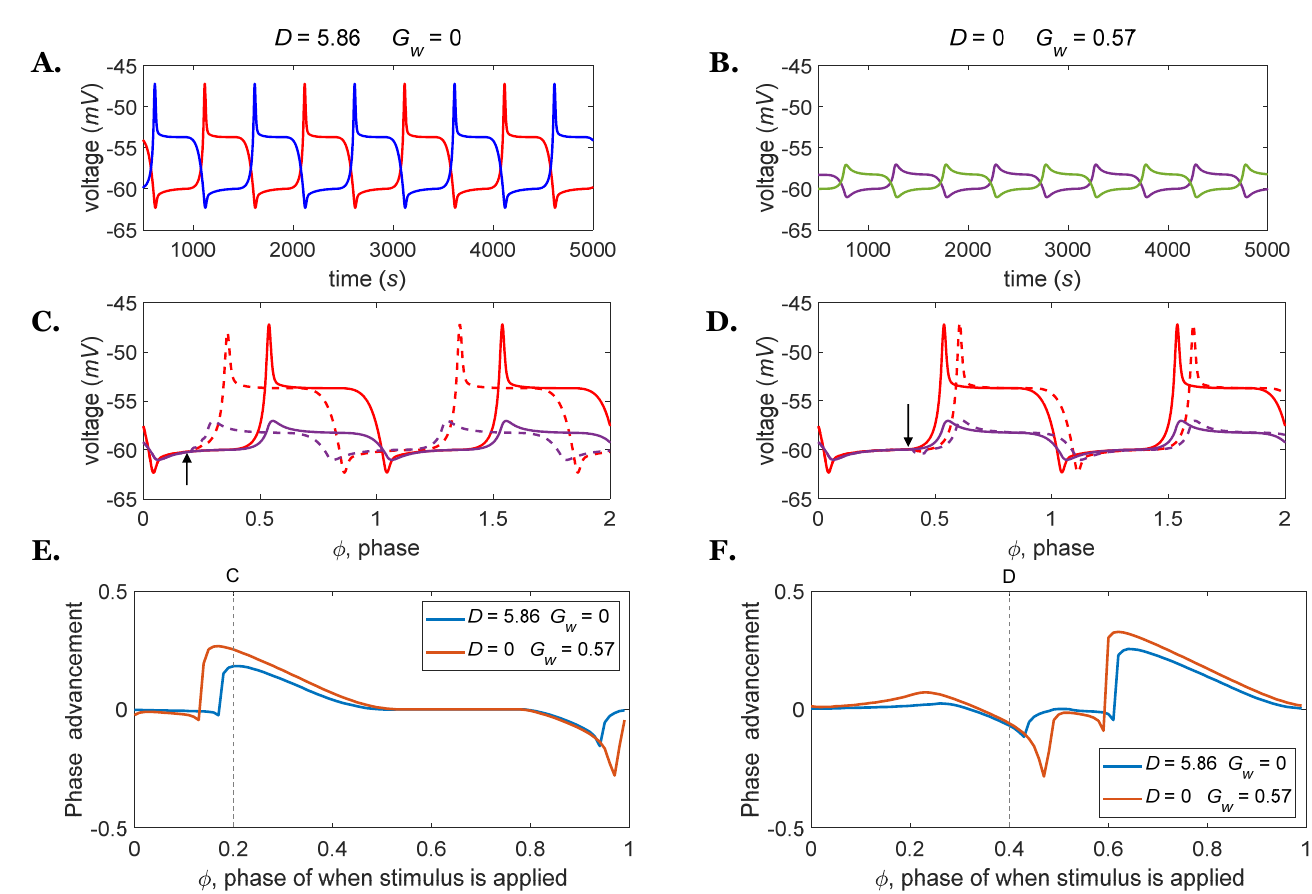
Figure 3. ( A ) Rhythm generators oscillating at 1 Hz driven by a descending drive, D = 5.86. ( B ) Rhythm generators oscillating at 1 Hz driven by weak excitatory connections, G w = 0.57. ( C , D ) Comparisons between perturbed (dashed lines) and nominal (solid lines) membrane voltages for rhythm generator extensors are shown in A (red lines) and B (purple lines); ( C ) the inhibitory perturbation current I s = 0.5 nA was applied to the RG flexor interneuron at ϕ = 0.2 with a duration of 5 percent of the oscillation period (arrow); ( D ) the excitatory perturbation current I s = 0.5 nA was applied to the RG flexor interneuron at ϕ = 0.4 with a duration of 5 percent of the oscillation period (arrow). ( E ) PRCs for the rhythm generator driven by D = 5.86 or G w = 0.57 at 1 Hz when perturbed by inhibitory stimuli of the same magnitude and duration as shown in part ( C ). ( F ) PRCs for the rhythm generator driven by D = 5.86 or G w = 0.57 at 1 Hz when perturbed by excitatory stimuli of the same magnitude and duration as shown in part ( D